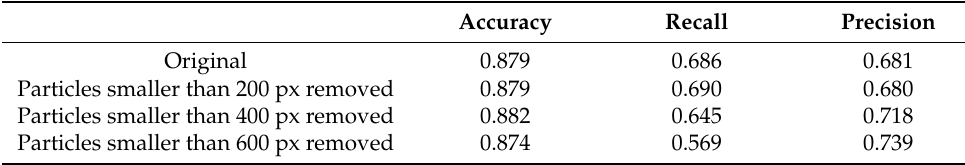
Table 14. Accuracy, recall, and precision (large number of particles).